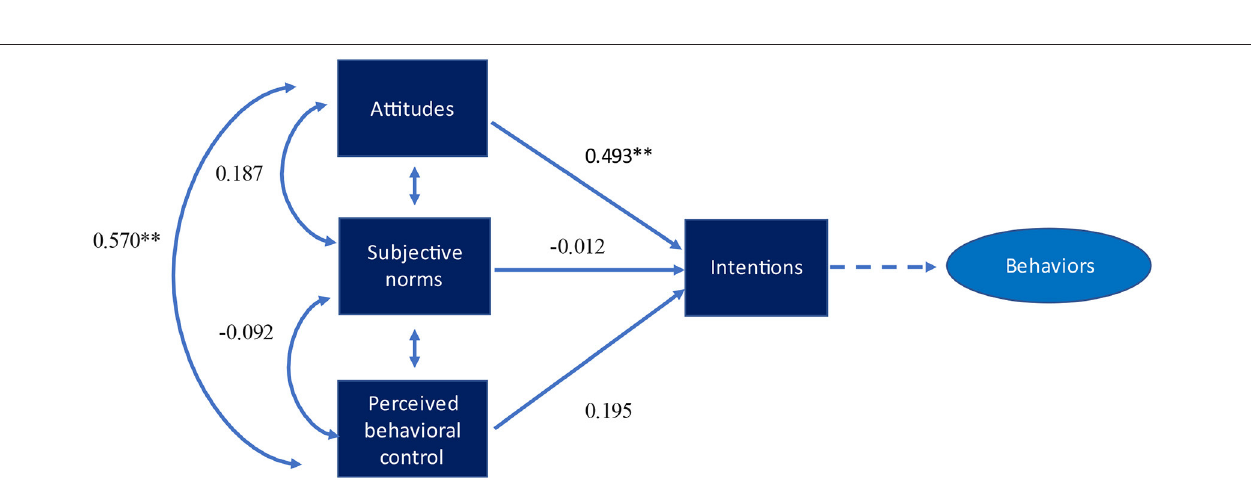
FIGURE 1 | Path model with standardized regression coefficients for whistleblowing—raising concerns in digital world. * p < 0.05; ** p < 0.01.